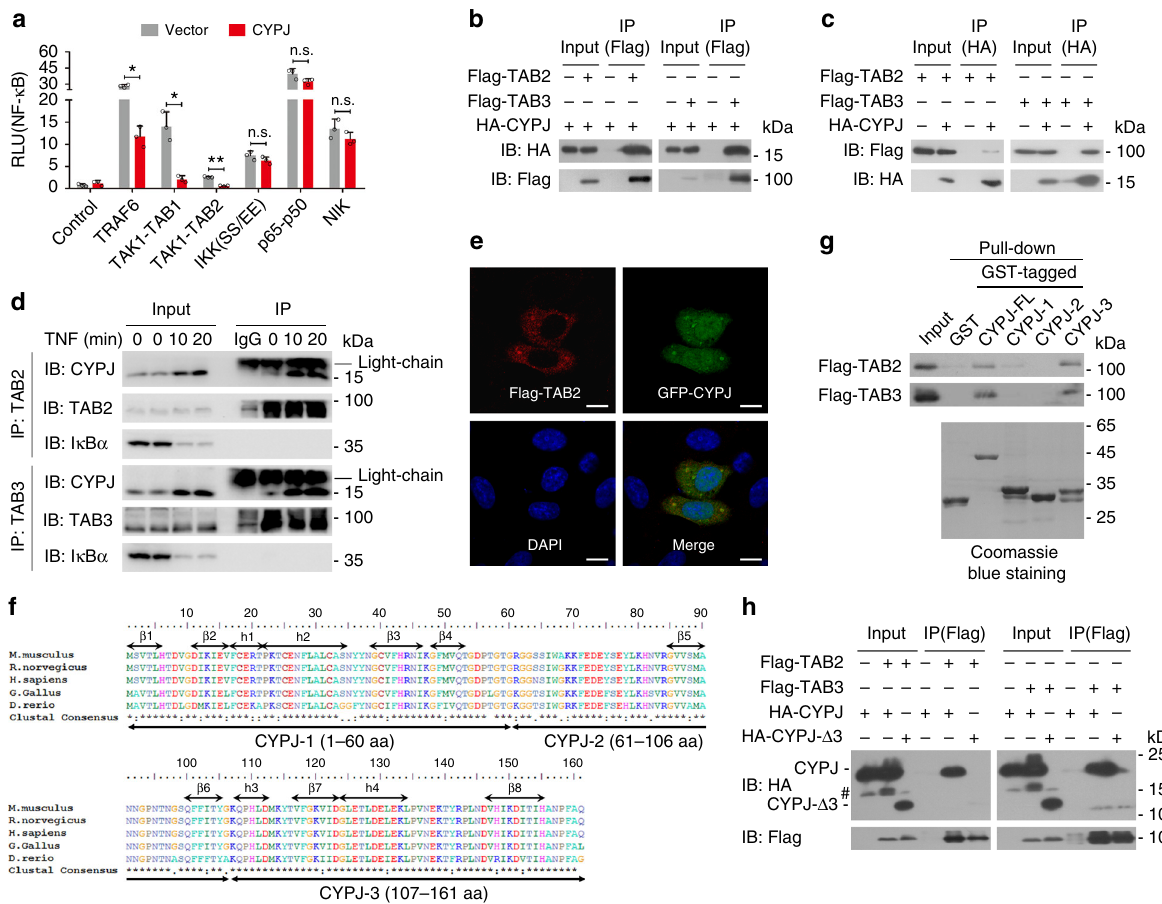
Fig. 3 The C-terminal of CYPJ interacts with TAB2 and TAB3. a Effects of CYPJ on NF- κ B reporter activation induced by individually transfected components of the NF- κ B signal pathway ( N = 3). b , c Reciprocal co-IP assays determine the interaction between HA-CYPJ and Flag-TAB2 or Flag-TAB3 in 293T cells. d Endogenous co-IP assays evaluate the interaction between CYPJ and TAB2/TAB3 with or without TNF treatment for different time points in 293T cells. e Immuno fl uorescence microscopy observing the colocalization of pEGFP-CYPJ and Flag-TAB2 in HeLa cells. Scale bars, 20 μ m. f Multiple sequence alignments of CYPJ proteins from different species. The three fragments of CYPJ are marked. g GST pull-down assays were performed using E. coli -expressed GST and GST-CYPJ fragments and lysates of 293T cells transfected with Flag-TAB2 or Flag-TAB3. h Co-IP assays detecting the interaction between Flag-TAB2/3 with HA-tagged FL or fragment-3 deleted CYPJ, # indicates a nonspeci fi c band. Error bars indicate S.D.; n.s. no signi fi cance, * p < 0.05, ** p < 0.01 (two-tailed Student ’ s t